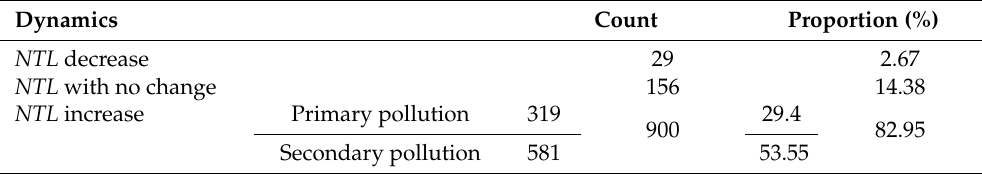
Figure 3. Statistics of NTL changes in PAs of Guangdong.